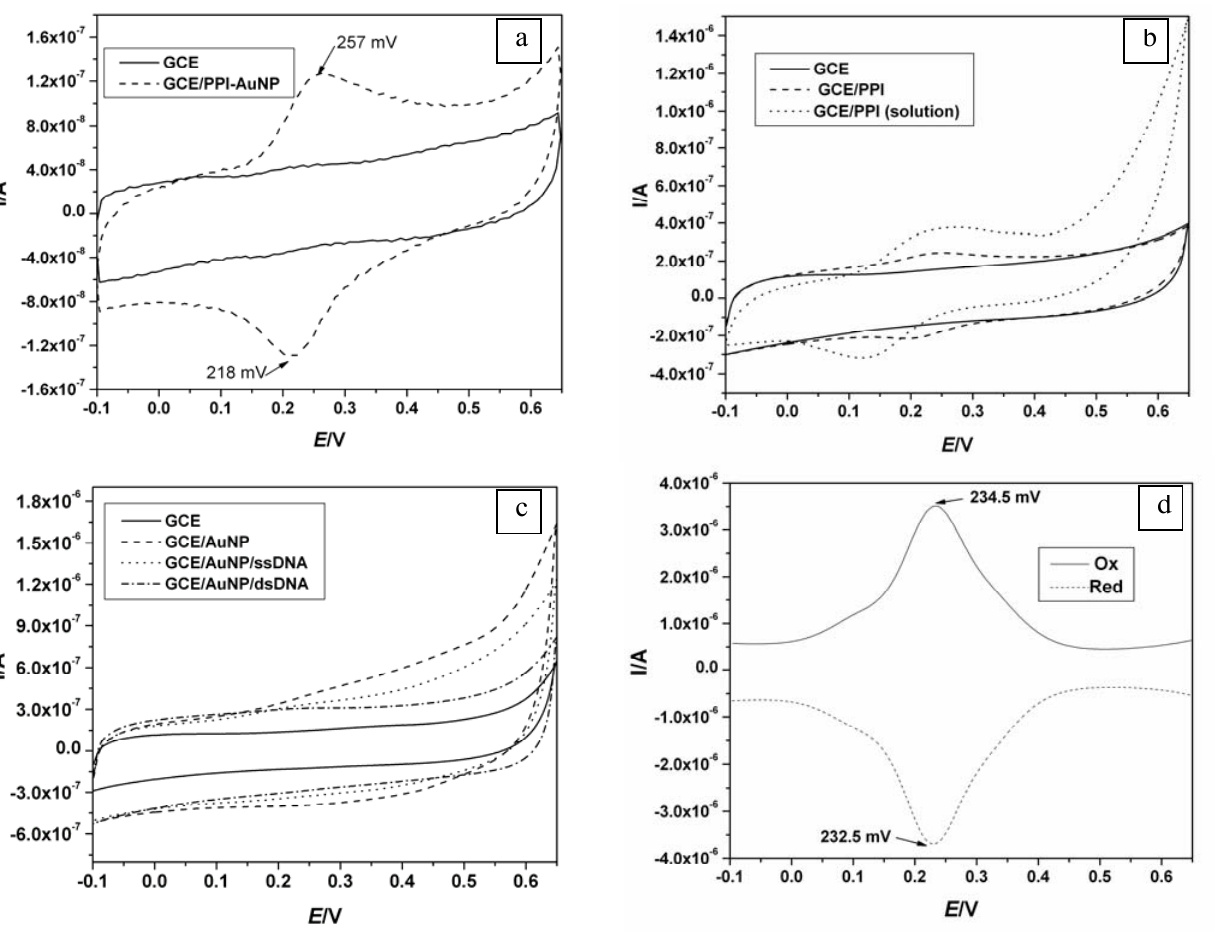
Figure 3. (a) CV of GCE and GCE/PPI-AuNP in PBS from -100 mV to 650 mV at 20 mV/s. (b) CV of 3 mM PPI solution on GCE and GCE/PPI. Background electrolyte is 10 mM PBS. (c) CV of GCE and GCE/AuNP with ssDNA and dsDNA in PBS. (d) Oxidative and reductive square wave voltammograms of GCE/PPI-AuNP in